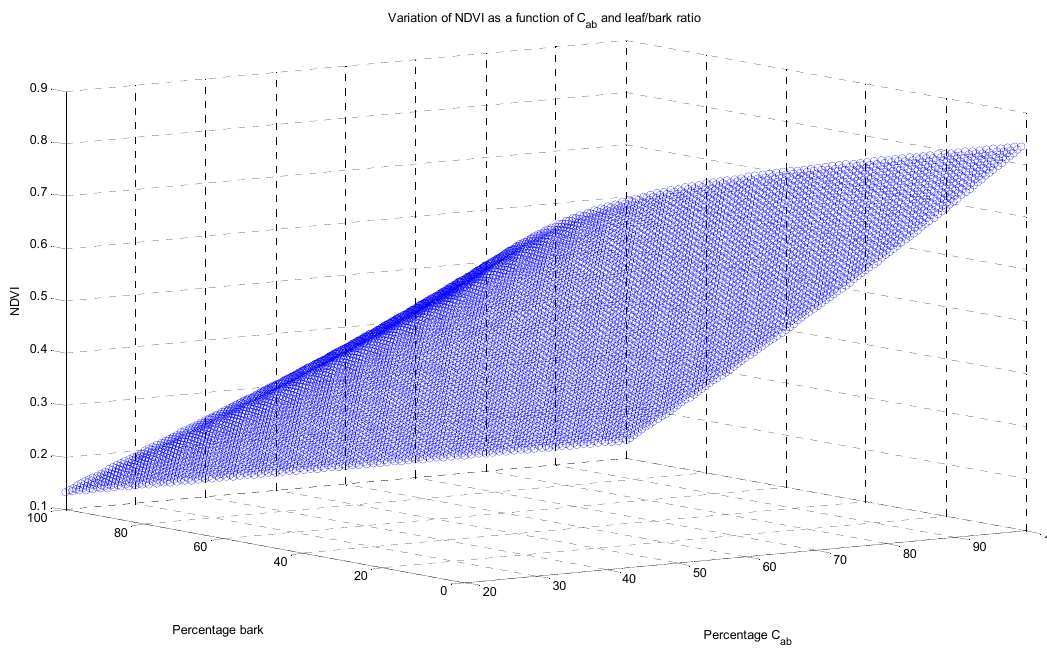
and leaf/bark ab